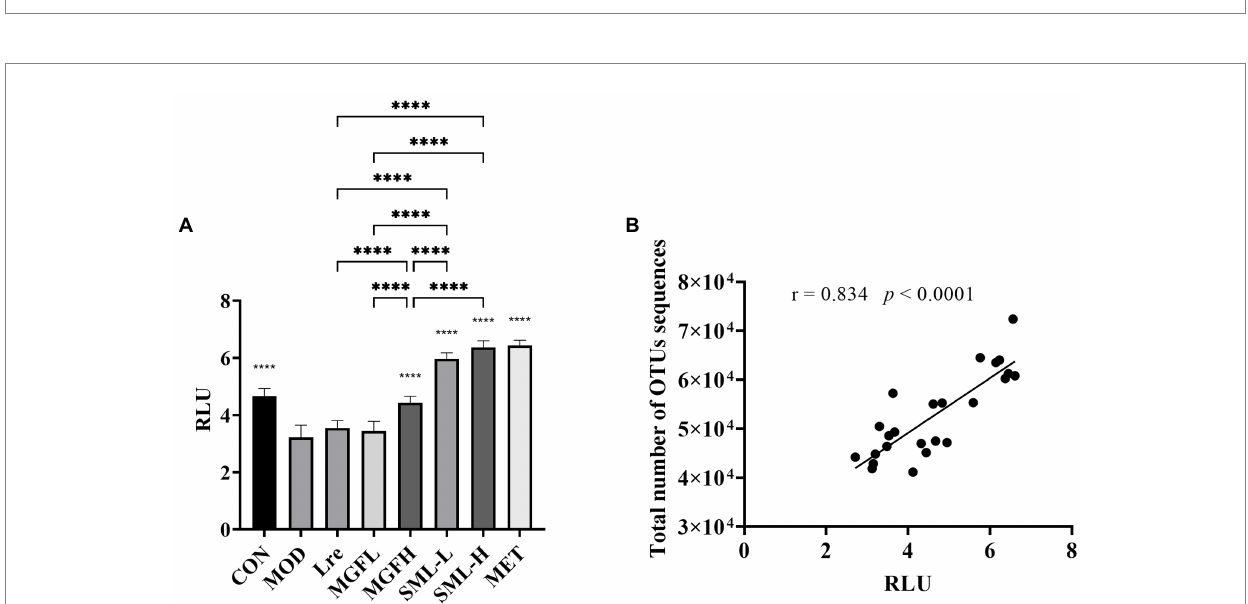
FIGURE 8 AI-2 content in feces. (A) was the AI-2 content in feces, **** p < 0.0001 compared with the MOD, and the SML and its components were compared. (B) was the Pearson correlation analysis between fecal AI-2 and total number of OTUs